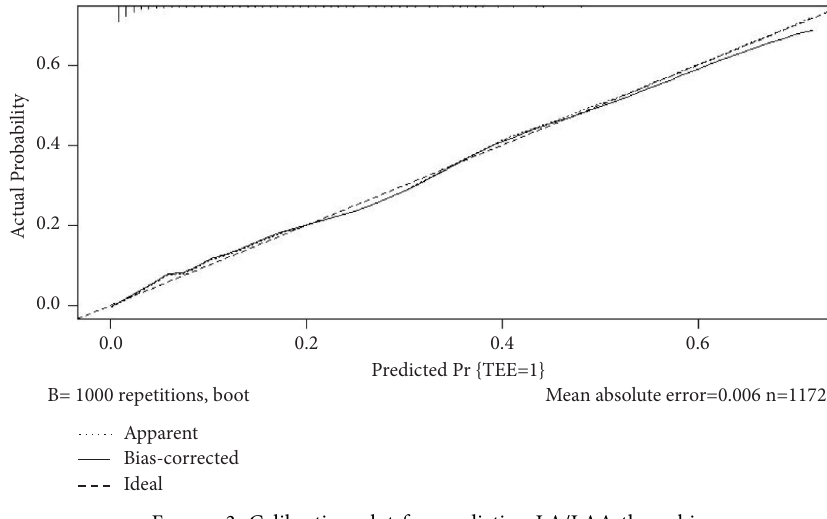
Figure 3: Calibration plot for predicting LA/LAA